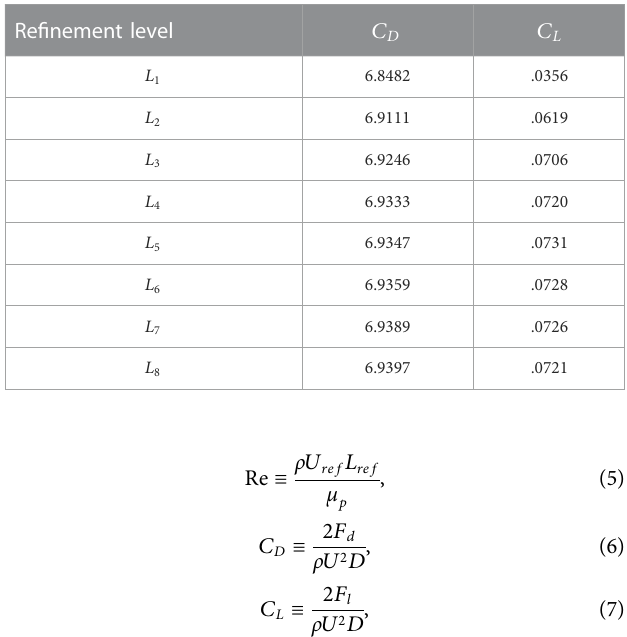
TABLE 2 Data on meshes of varying re fi nement levels. TABLE 3 Grid convergence